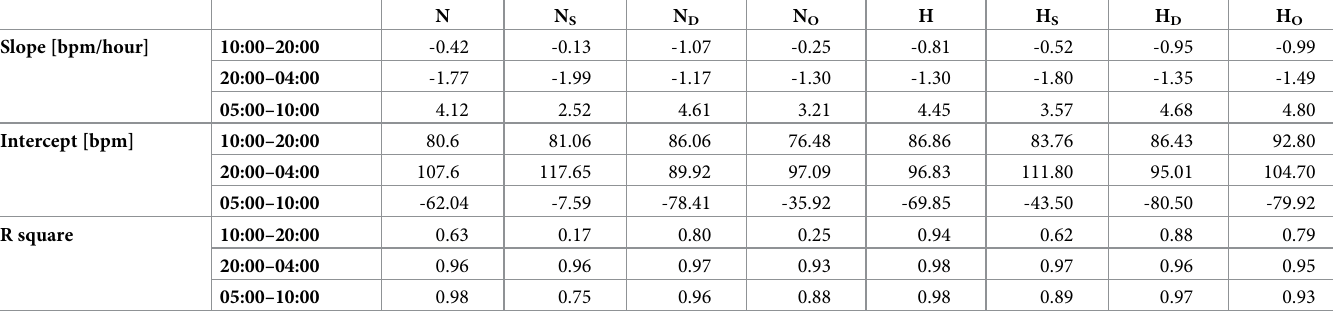
Table 2. Slope, intercept and R 2 values of the linear regression calculated in the three time periods in the eight subject groups. N